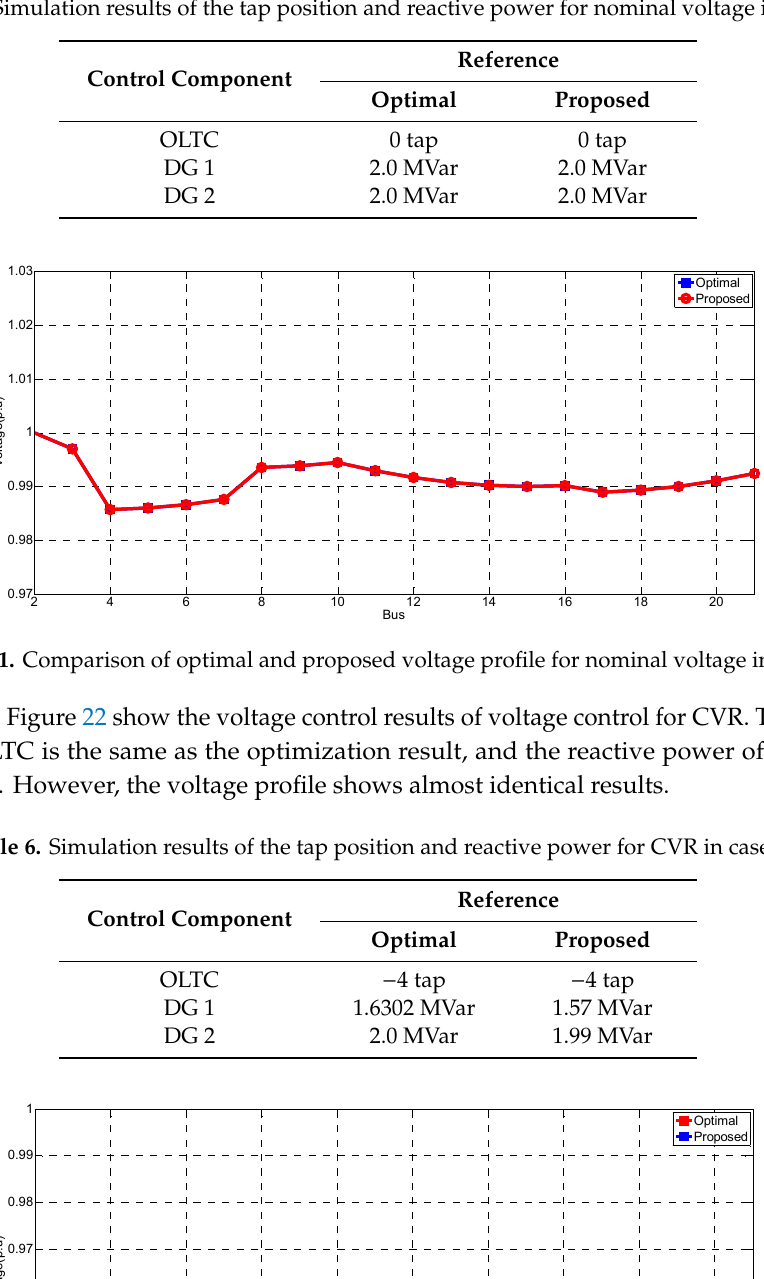
Figure 20. Single diagram of distribution network of case 2.